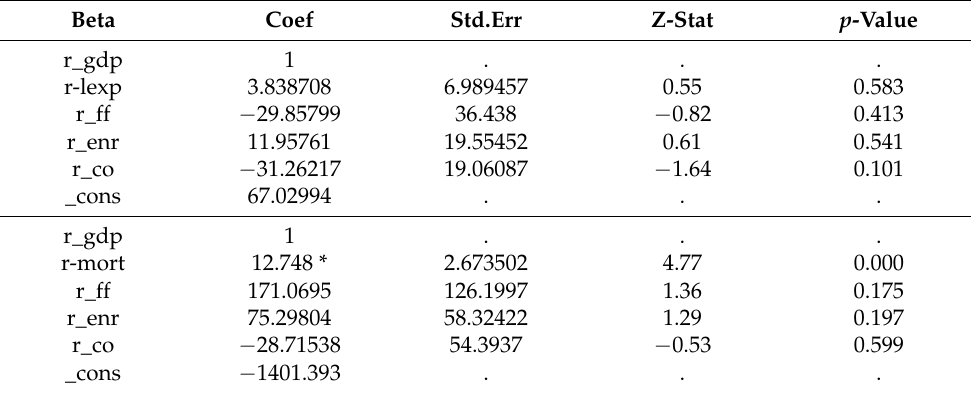
Table 13. Johansen normalization restriction imposed for Russia. Beta Coef Std.Err Z-Stat